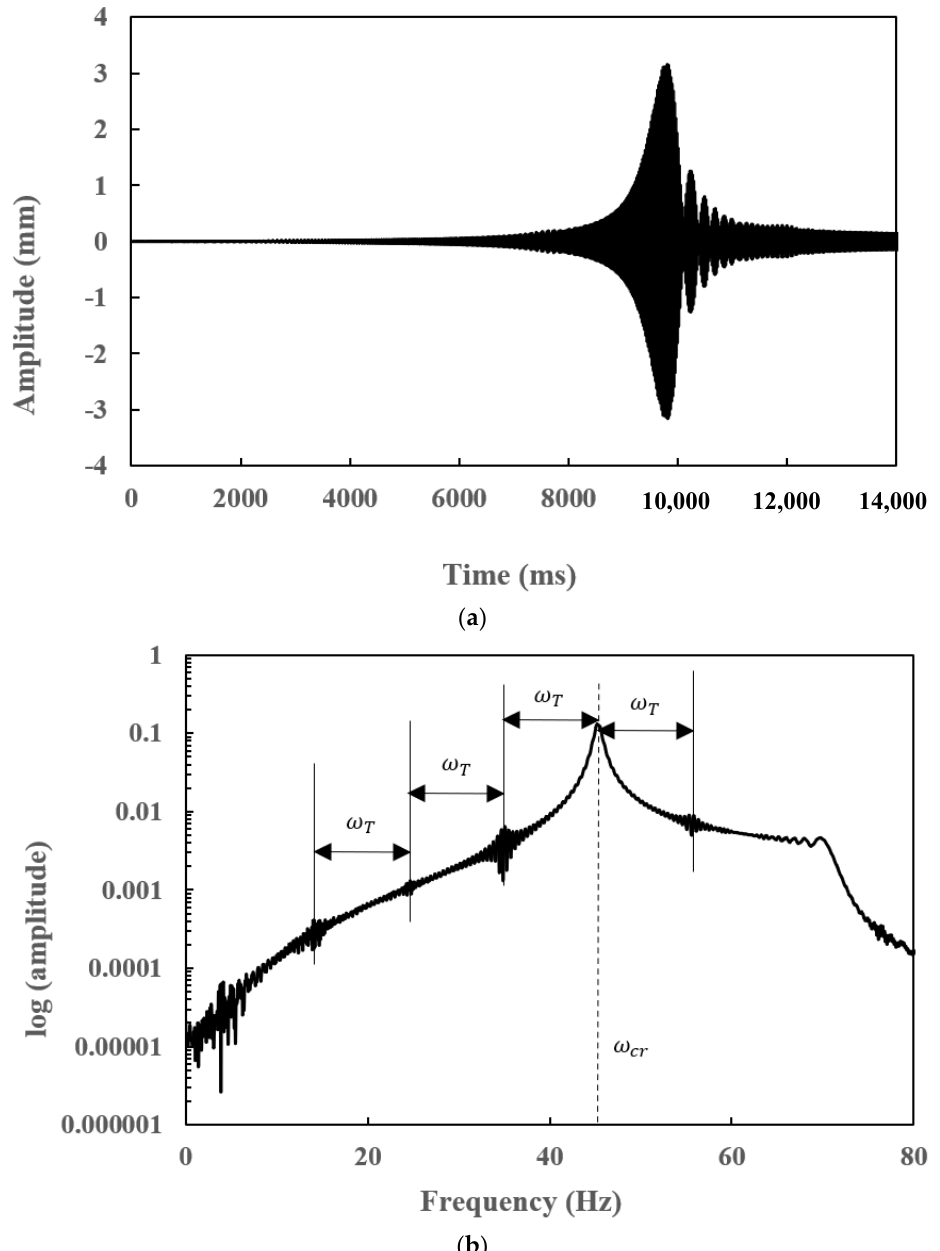
Figure 14. Transient ( a ) time response and corresponding ( b ) FFT of a slant − cracked EG rotor − bearing system with an angular acceleration of 30 rad/s 2 , and torsional frequency ( 𝜔 (cid:3021) ) = 65 rad/s for 𝛼(cid:3364) = 0.3 .